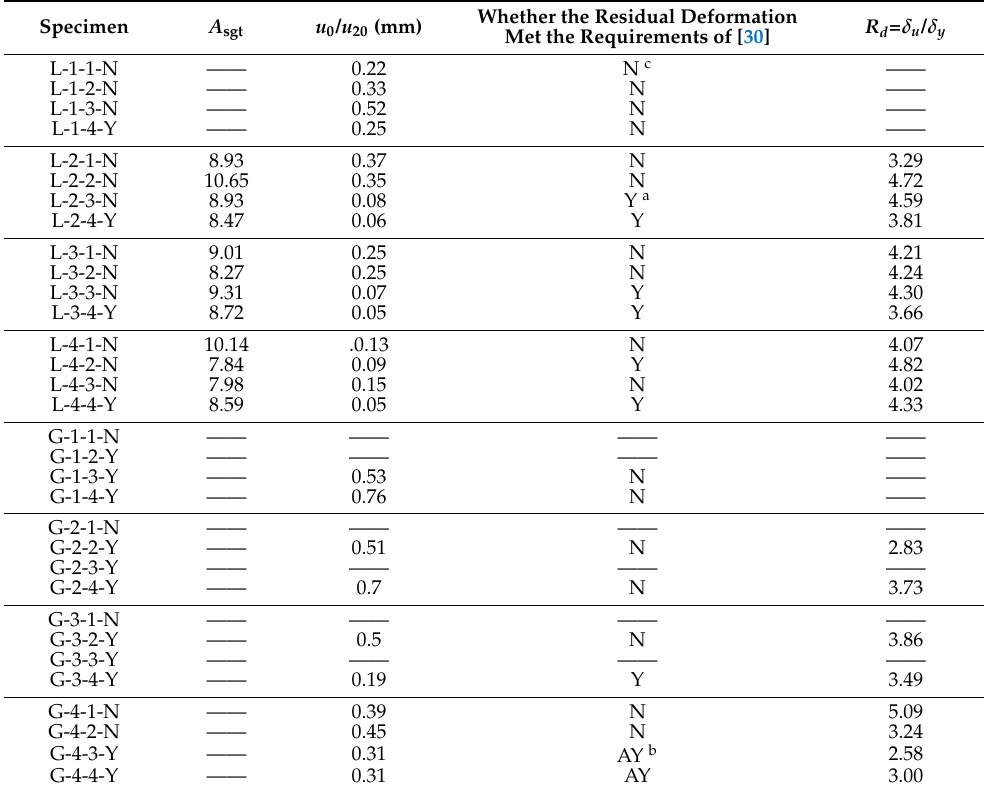
Table 4. Test results of ductility and residual